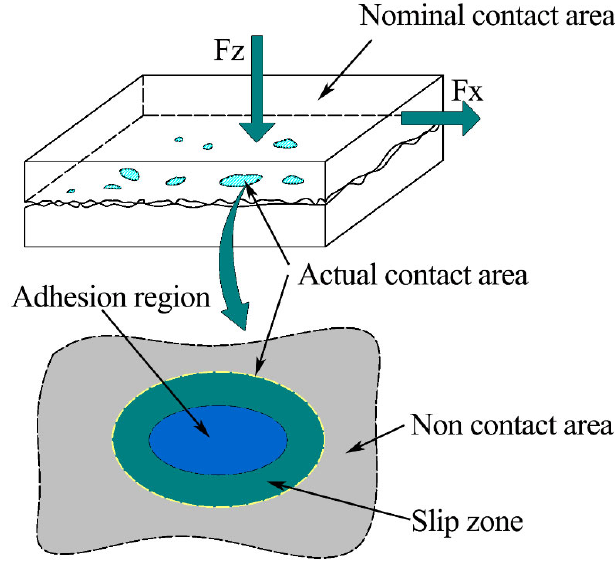
Figure 2. Actual contact diagram of micro ‐ convex body.